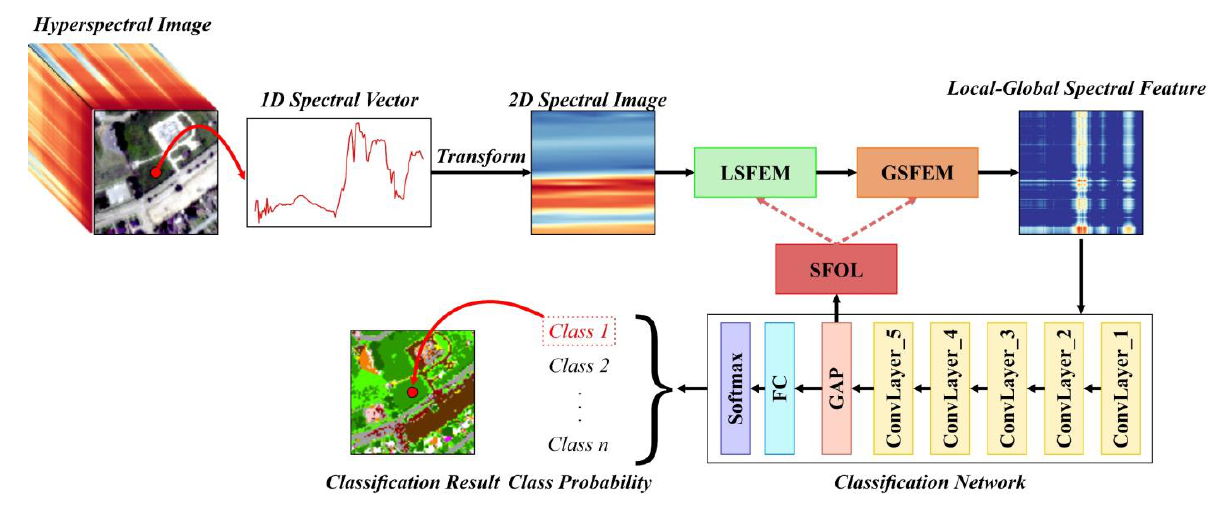
Figure 1. The overview of the proposed method.